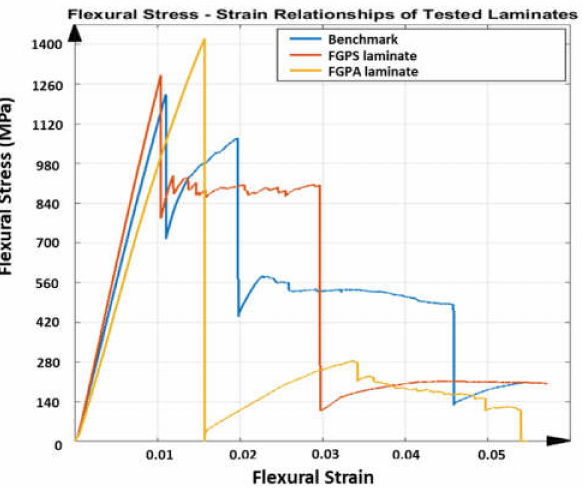
Figure 7. Flexural stress–strain curves for the benchmark, symmetric (FGPS) and asymmetric (FGPA) configurations.